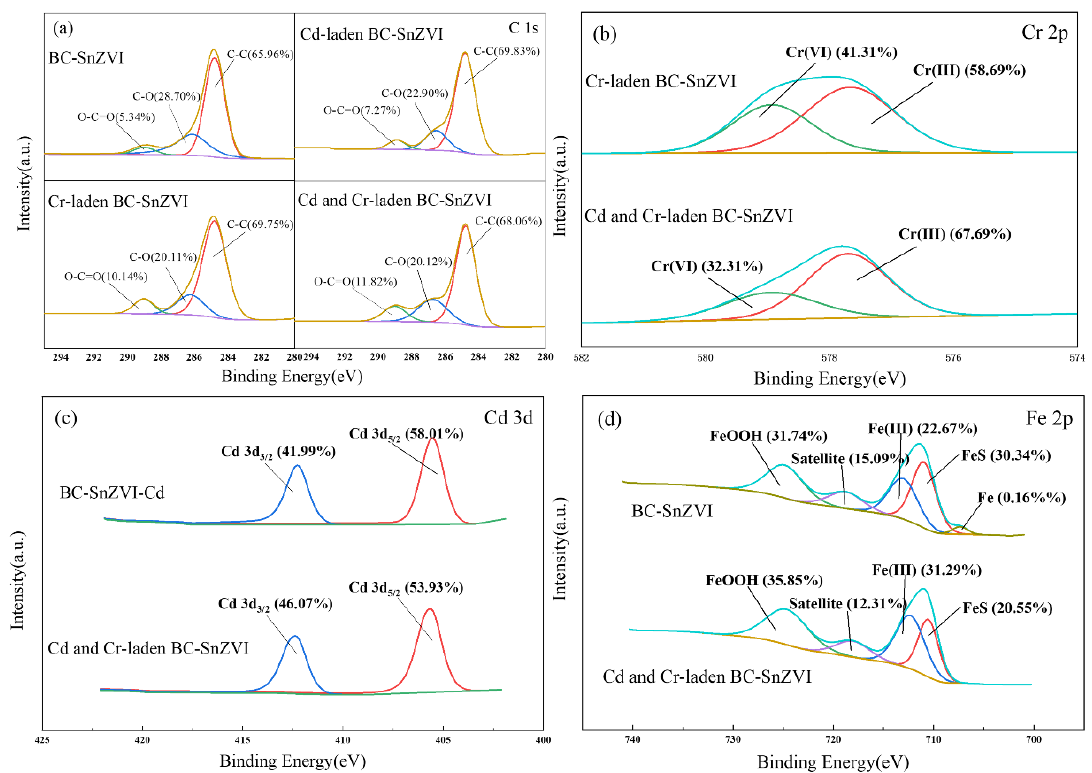
Figure 7. FTIR spectra of BC-SnZVI before and after the adsorption of Cr(VI) and Cd(II).